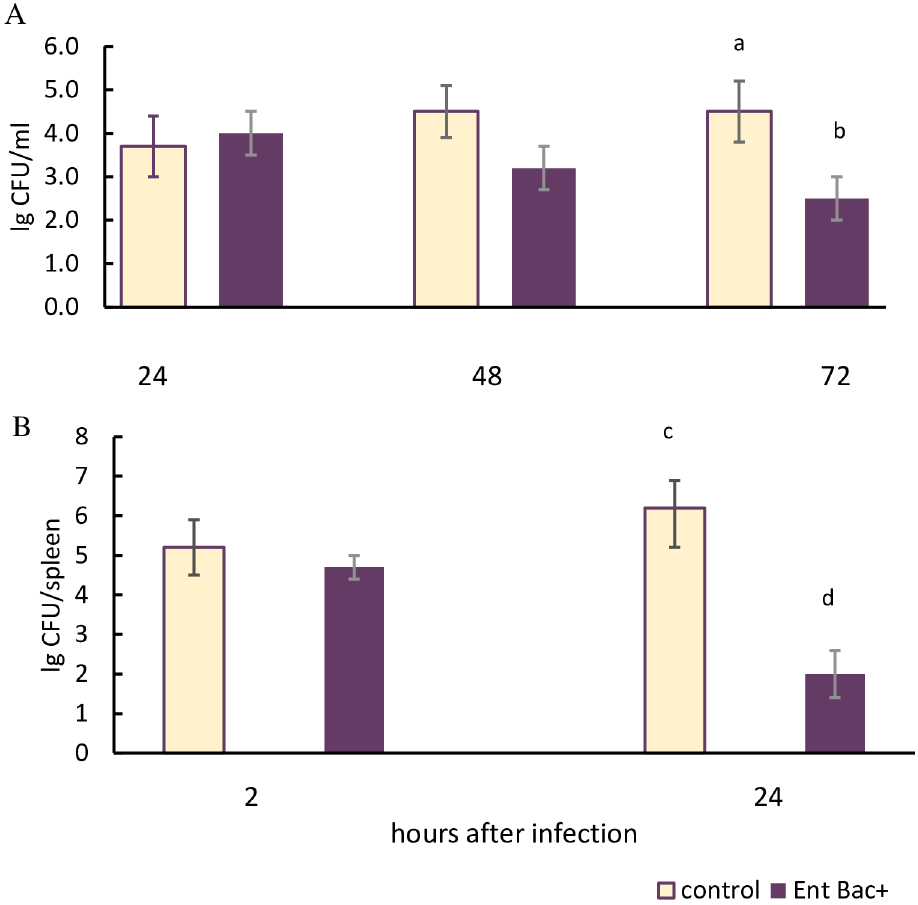
Fig 5. The bacterial count at different stages of GBS infection in mice after vaginal and oral vaccination. Vaginally vaccinated immune mice (n = 60, 10 mice per each point) were infected intravaginally with GBS (H36 Iac) (A). At the same time, orally vaccinated immune mice (n = 40, 10 mice per each point) were infected intraperitoneally with the same strain (B). After infection, the bacterial burden in CFU within the vaginal cavity (A) and the spleen (B) was calculated and expressed as log10. (A) Means with letter a and b differ significantly (p < 0,05).(B) Means with letter c and d differ significantly (p <